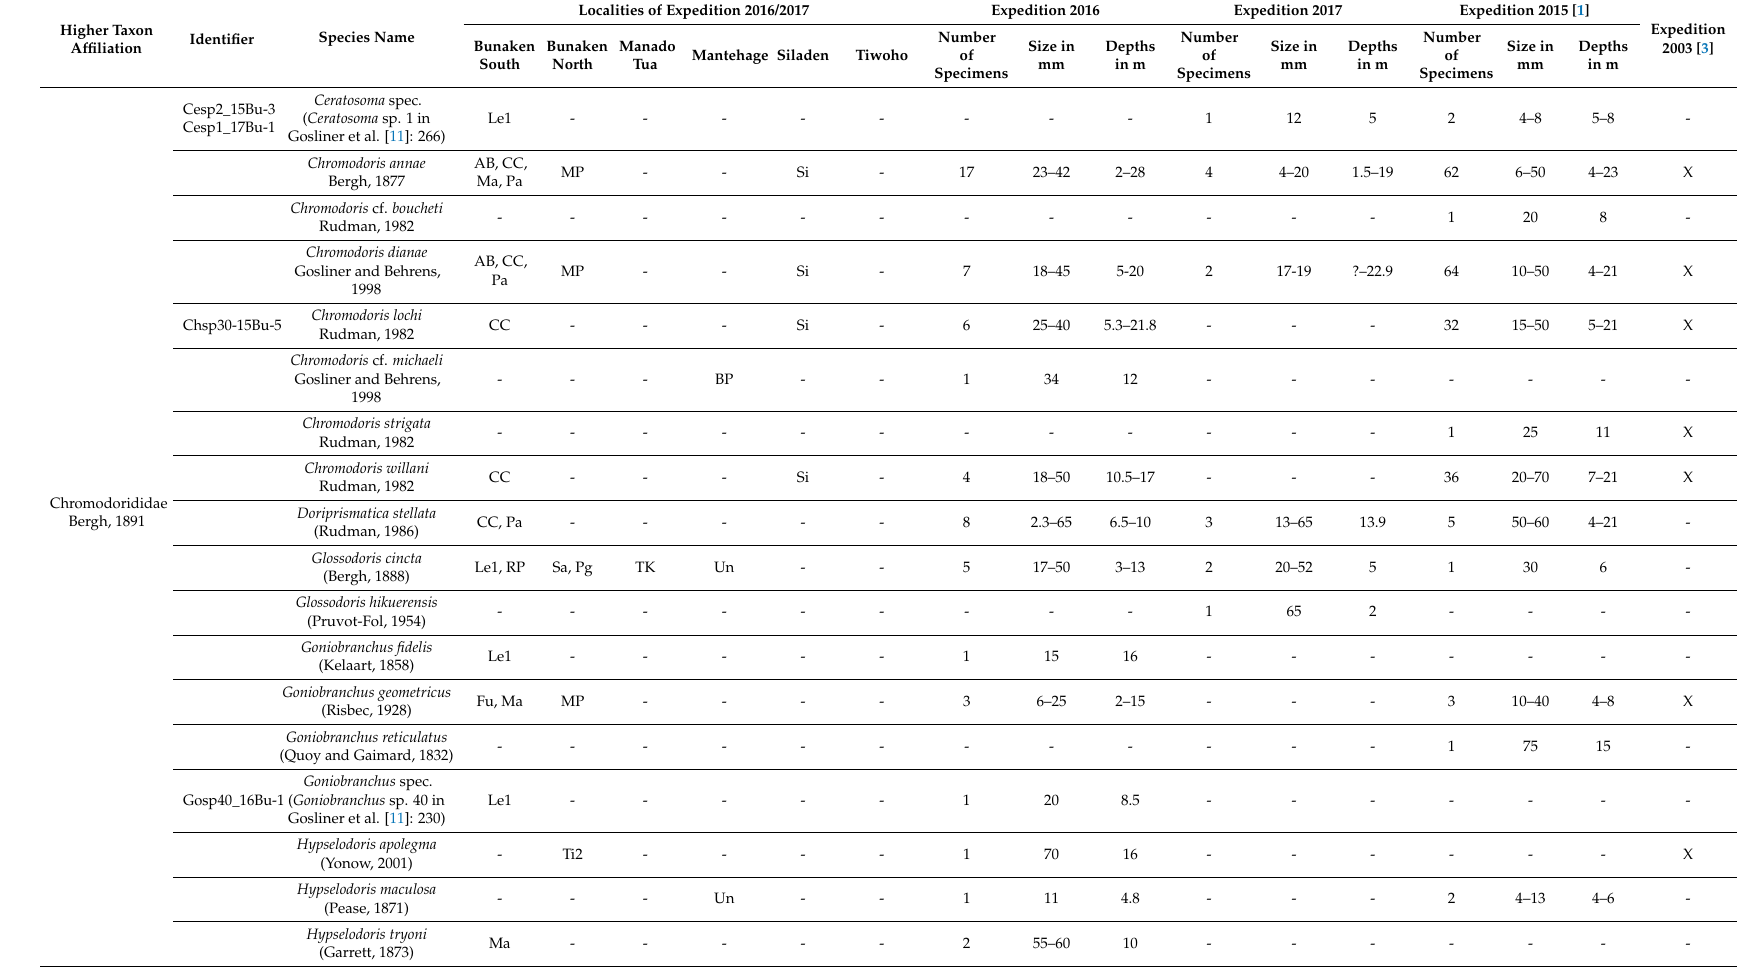
Glossodoris hikuerensis (Pruvot-Fol,